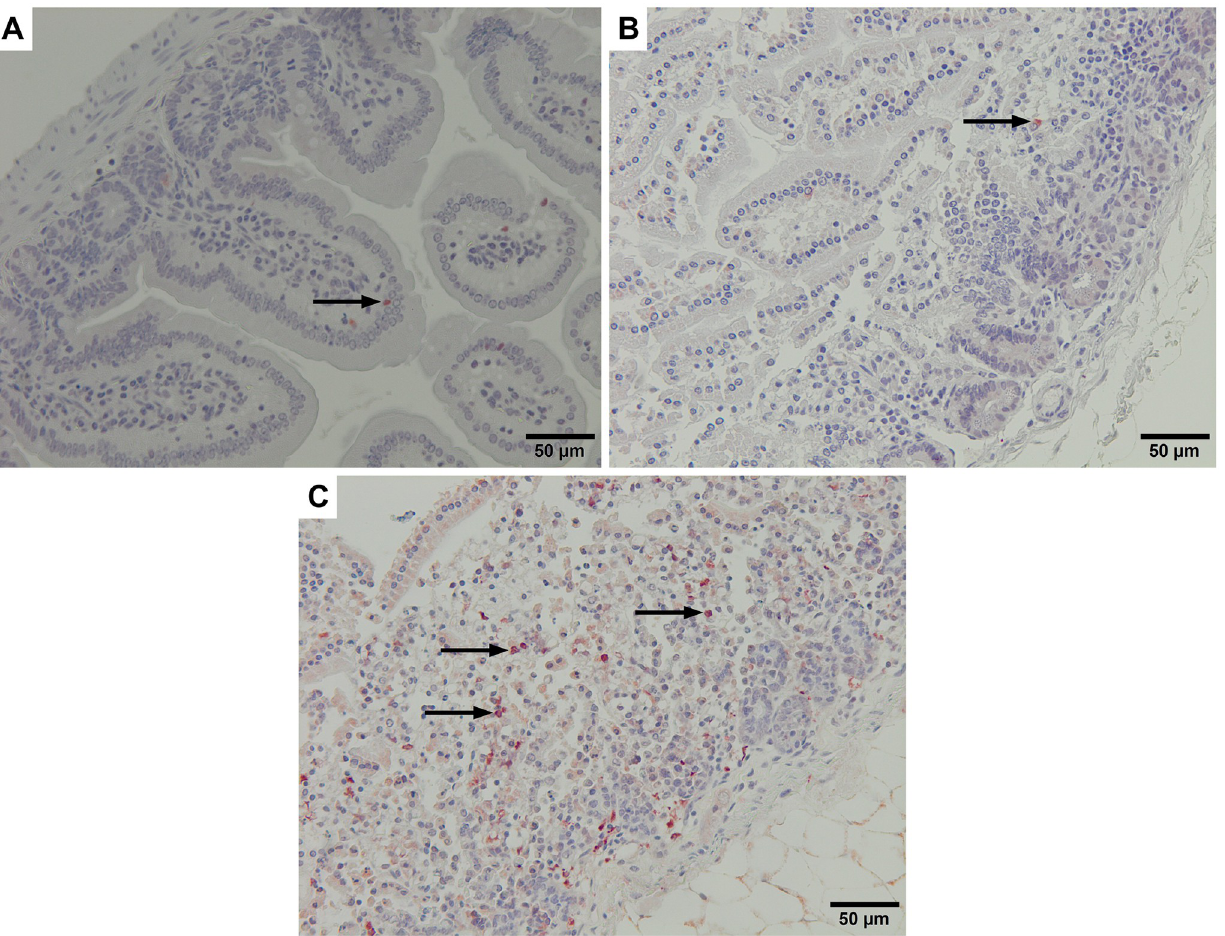
Fig 8. Mouse intestine subjected to the ABC method and hematoxylin counterstain. Cleaved caspase 3 in non-infected fresh intestine (A), non-infected incubated intestine (B) and infected and incubated intestine (C) all of them showing caspase 3+ cells (arrow). Specific areas of the infected and incubated intestine (C) showed a higher number of caspase 3+ cells in the lamina propria (arrows), compared with the fresh and the incubated and non-infected intestine.